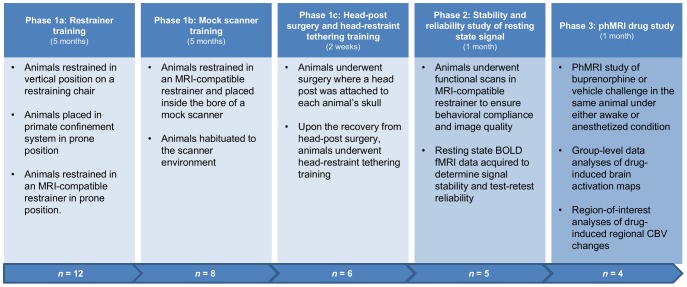
Study protocol of awake imaging in non-human primates.Initial Phase 1a–c focus on the training procedures to reduce animal movement/stress during awake imaging; Phase 2 was the assessment of the stability of resting state signal and its test-retest reliability; Phase 3 was the within-subject pharmacological challenge study, where buprenorphine (0.03 mg/kg i.v.) and vehicle were given to the same animals under awake and anesthetized conditions.